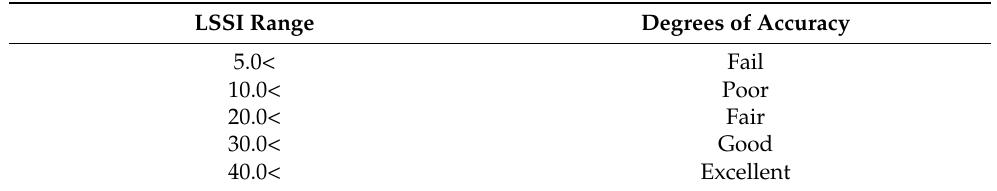
Table 1. Evaluation criteria for the LSSI technique.